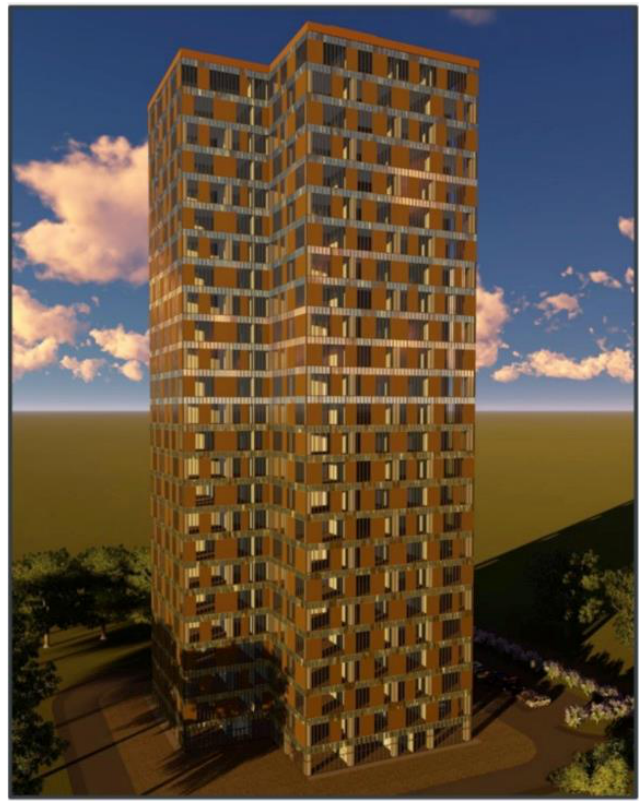
Figure 22. A model of an office high-rise building with a height of 121.7 m with the Autodesk Revit program.